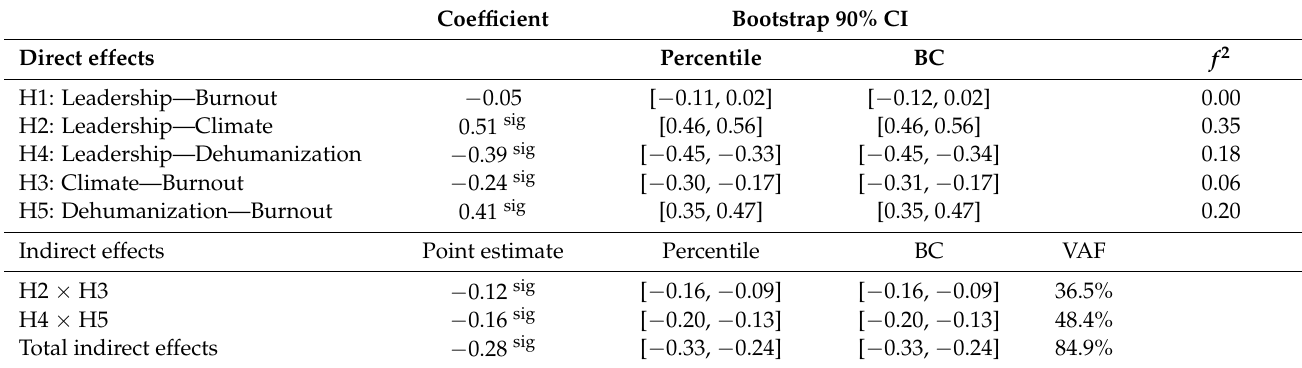
Table 2. Mediating effects